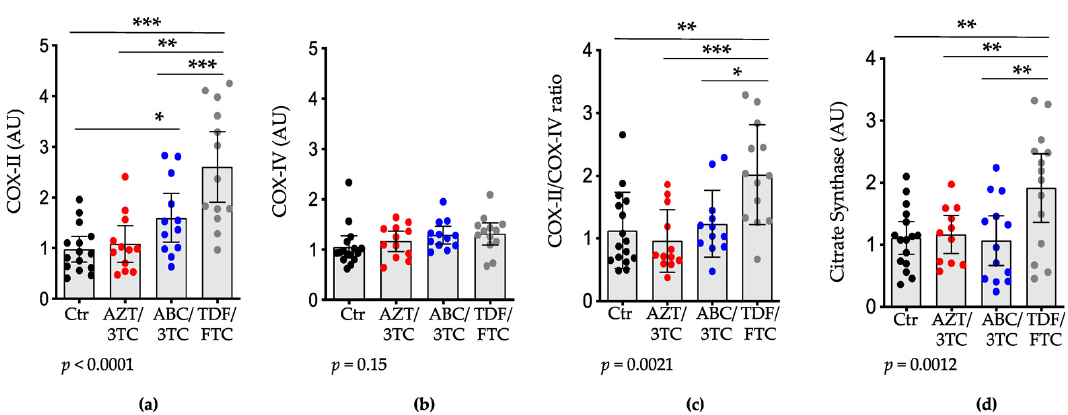
Figure 3. Placental mRNA levels of COX-II and citrate synthase are elevated in pregnant mice treated with TDF/FTC. Mice were treated with either AZT/3TC (red dots), ABC/3TC (blue dots), TDF/FTC (grey dots), or water (control; black dots) throughout pregnancy. Placentas were col- lected at gestational day 15. Placental mRNA expression of ( a ) COX-II, ( b ) COX-IV, ( c ) COX-II to COX-IV ratio; and ( d ) citrate synthase. Data are scatter dot plots with mean and 95% confidence interval (n = 16 placentas from 6 litters for control; n = 11–12 placentas from 6 litters for AZT/3TC; n = 12–13 placentas from 5 litters for ABC/3TC; n = 13–14 placentas from 6 litters for TDF/FTC). Statistical comparisons by mixed-effects modelling to control for litter effects (using treatment as a fixed effect and litter as a random effect). * = p < 0.05, ** = p < 0.01, *** = p < 0.001. The p -values below the panels are for the model. AZT, zidovudine; 3TC, lamivudine; ABC, abacavir; FTC, emtricitabine; TDF, tenofovir; COX-II, cytochrome c-oxidase subunit-II; COX-IV, cytochrome c-oxidase subunit IV; AU, arbitrary